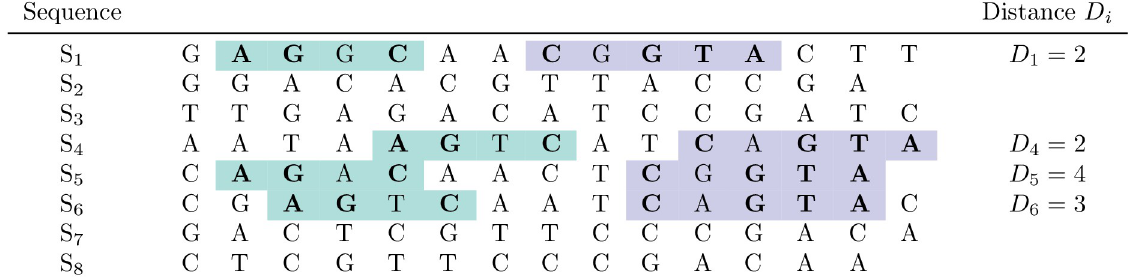
Fig 4. Two quartet blocks, similar as in Fig 3, but involving S 1 , S 4 , S 5 , S 6 , and with distances D 1 = D 4 = 2, D 5 = 3 and S 6 = 4. Here, we say that the distances weakly support the topology S 1 S 4 | S 5 S 6 , since only D 1 and D 4 are equal, while D 5 and D 6 are different from each other and from D 1 and D 4